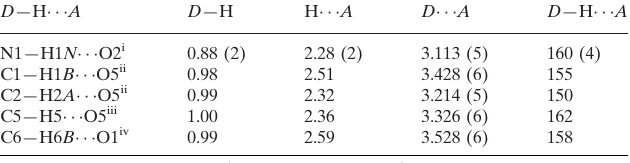
Hydrogen-bond geometry (A˚ , (cid:2)